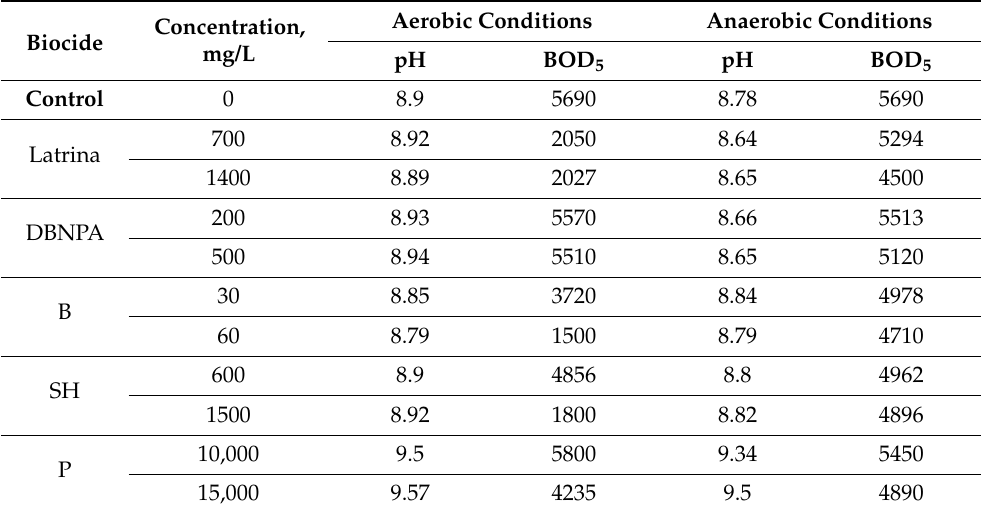
Table 8. BOD 5 and pH values for control and biocide-pretreated FS samples incubated for 10 days under aerobic or anaerobic